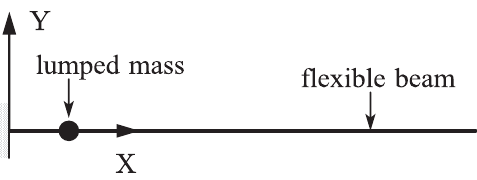
Figure 8. Initial configuration of numerical example 1.